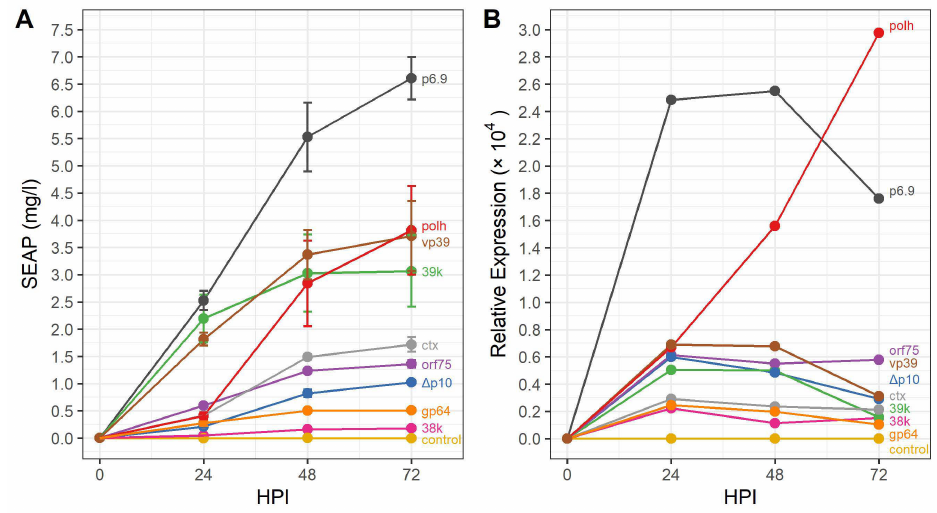
Figure 3. Production of extracellular SEAP from selected Ac MNPV promoters. ( A ) Yield of SEAP (mg/L) of culture supernatants measured using a colorimetric SEAP activity assay and ( B ) relative transcript abundance measured using RT-qPCR at 24, 48, and 72 h post